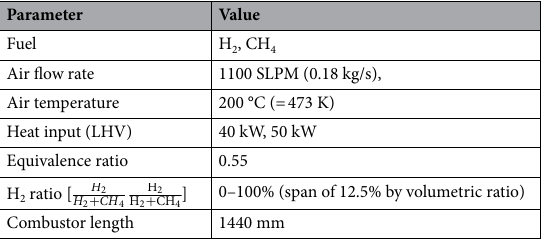
Table 3. Experimental test